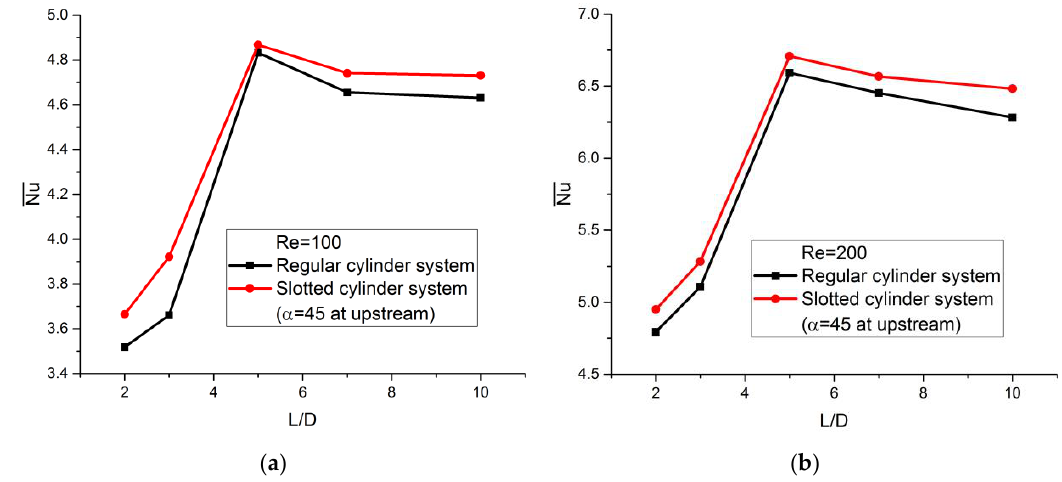
Figure 21. The time mean Nusselt number of the array as a slit at α = 45° is employed on the upstream cylinder of the tandem array with different cylinder distance: ( a ) Re = 100; ( b ) Re = 200.